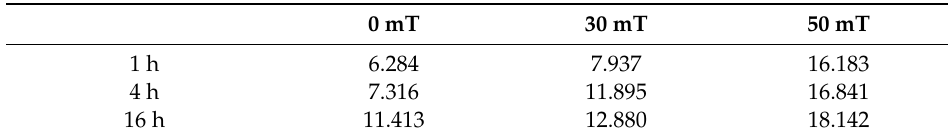
Figure 9. Volume fraction of the δ phase in the EMS-LSFed Inconel 718 superalloy samples prepared with di ff erent electromagnetic field intensities. Table 9. The influence of the electromagnetic field within the average volume fraction of the δ phase for di ff erent aging times